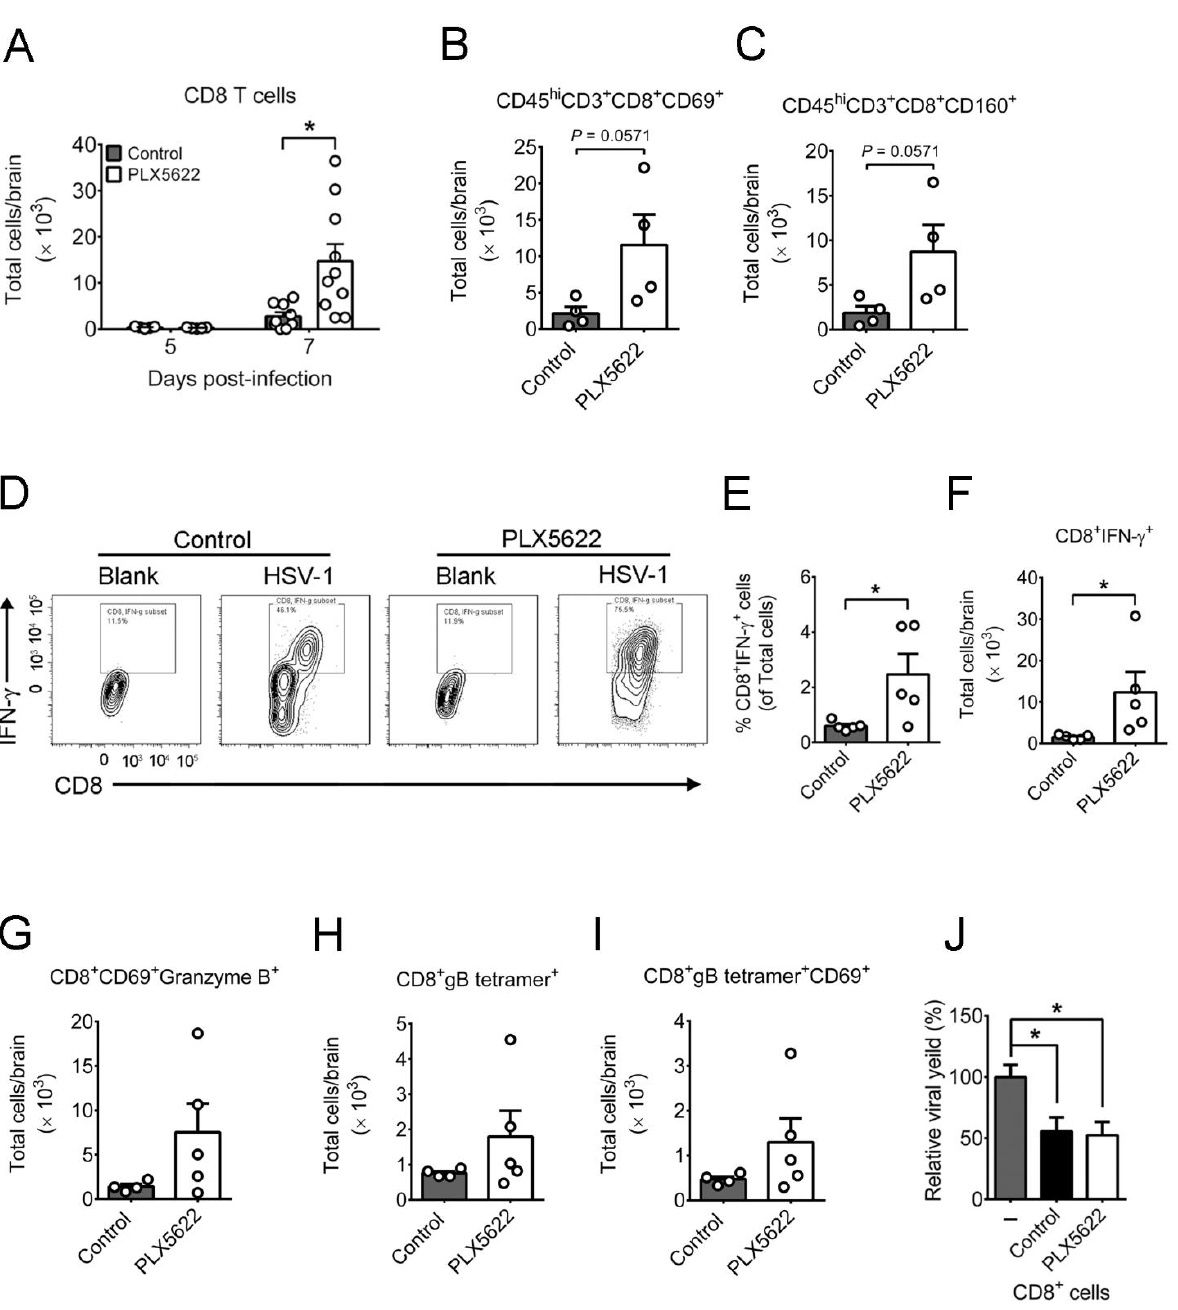
Figure 5. Effects of PLX5622 on the leukocyte responses in brains of infected mice. The brains of infected mice fed with control chow or the chow containing PLX5622 were harvested on the indicated days or day 7 post-infection and assayed for ( A ) CD8 + T cells, ( B ) early activated CD8 T (CD45 hi CD3 + CD8 + CD69 + ) cells, ( C ) cytotoxic CD8 T (CD45 hi CD3 + CD8 + CD160 + ) cells, ( D – F ) CD8 + IFN- γ + T cells, ( G ) CD8 + CD69 + granzyme B + T cells, ( H ) virus-specific CD8 T (CD8 + gB tetramer + ) cells, and ( I ) activated virus-specific CD8 T (CD8 + gB tetramer + CD69 + ) cells by flow cytometry. ( J ) Primary mouse brain neurons (1 × 10 5 cells) were infected with HSV-1 (MOI = 0.001) for 24 h, co-cultured without ( – ) or with 5 × 10 5 CD8 T cells from brains of infected mice fed with control chow or the chow containing PLX5622 (PLX5622) and harvested 48 h later for virus titration. The mean of the neuron group was set as 100%. The data represent means + SEM (error bars) of 4 – 14 samples per group obtained from at least two independent experiments. *, p < 0.05.